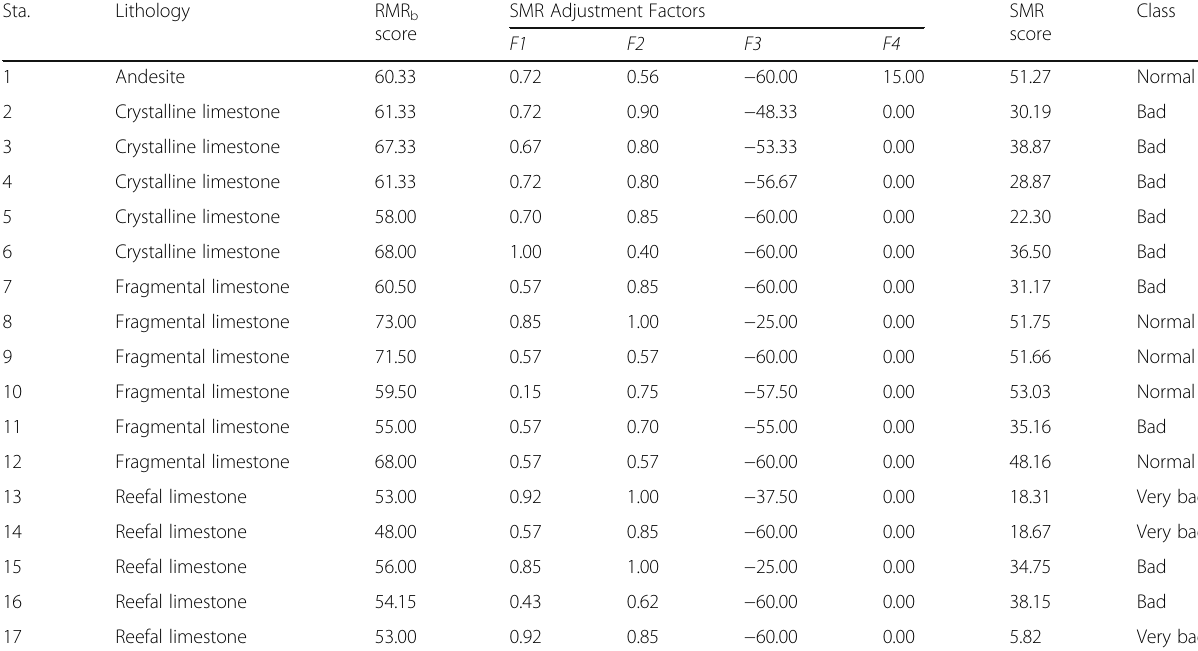
Table 16 The summary of measured SMR